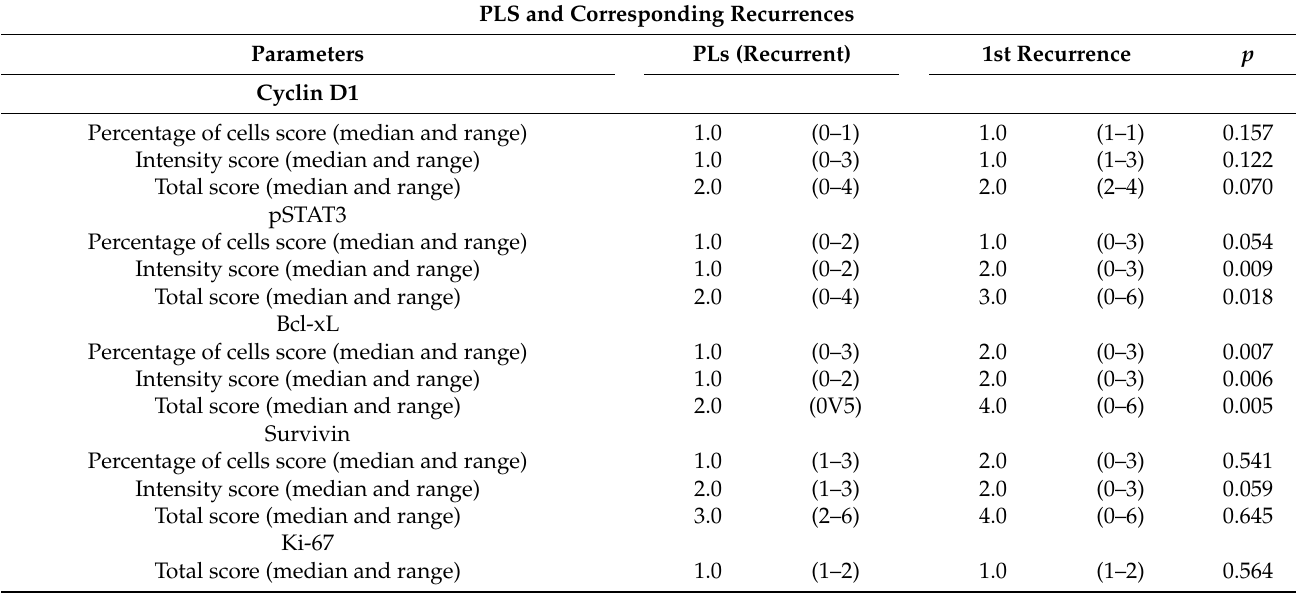
Table 7. Comparison of immunohistochemical results of various studied molecules between primary oral leukoplakia lesions (PLs) that recurred and their corresponding first